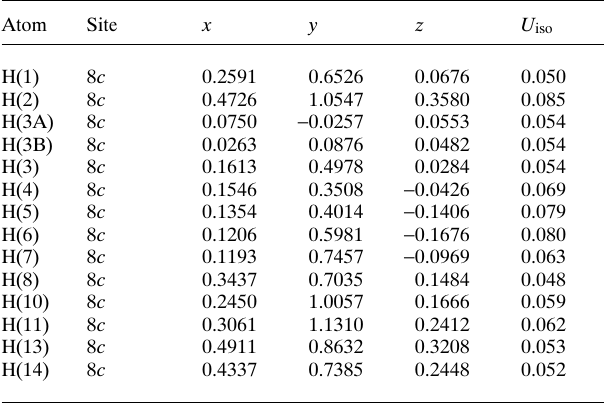
Table 2. Atomic coordinates and displacement parameters (in Å 2 )